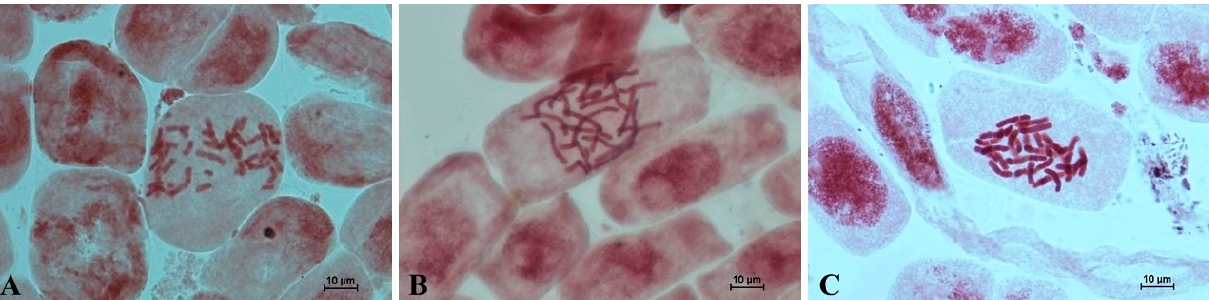
Figure 3. Microscopic view of chromosomes during mitotic divisions: ( A ) diploid cultivar ‘Dutch Master’; ( B ) triploid cultivar ‘Yellow Cheerfulness’; and ( C ) tetraploid cultivar ‘Ice Follies’.